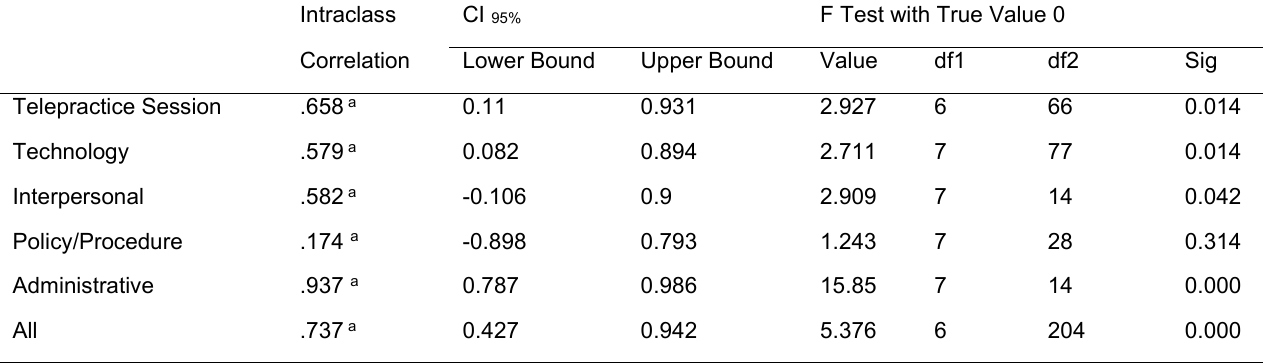
Indirect Providers ICC Calculation in SPSS Using Single-Rating, Absolute-Agreement, 2-Way Random-Effects Model, Average Measures